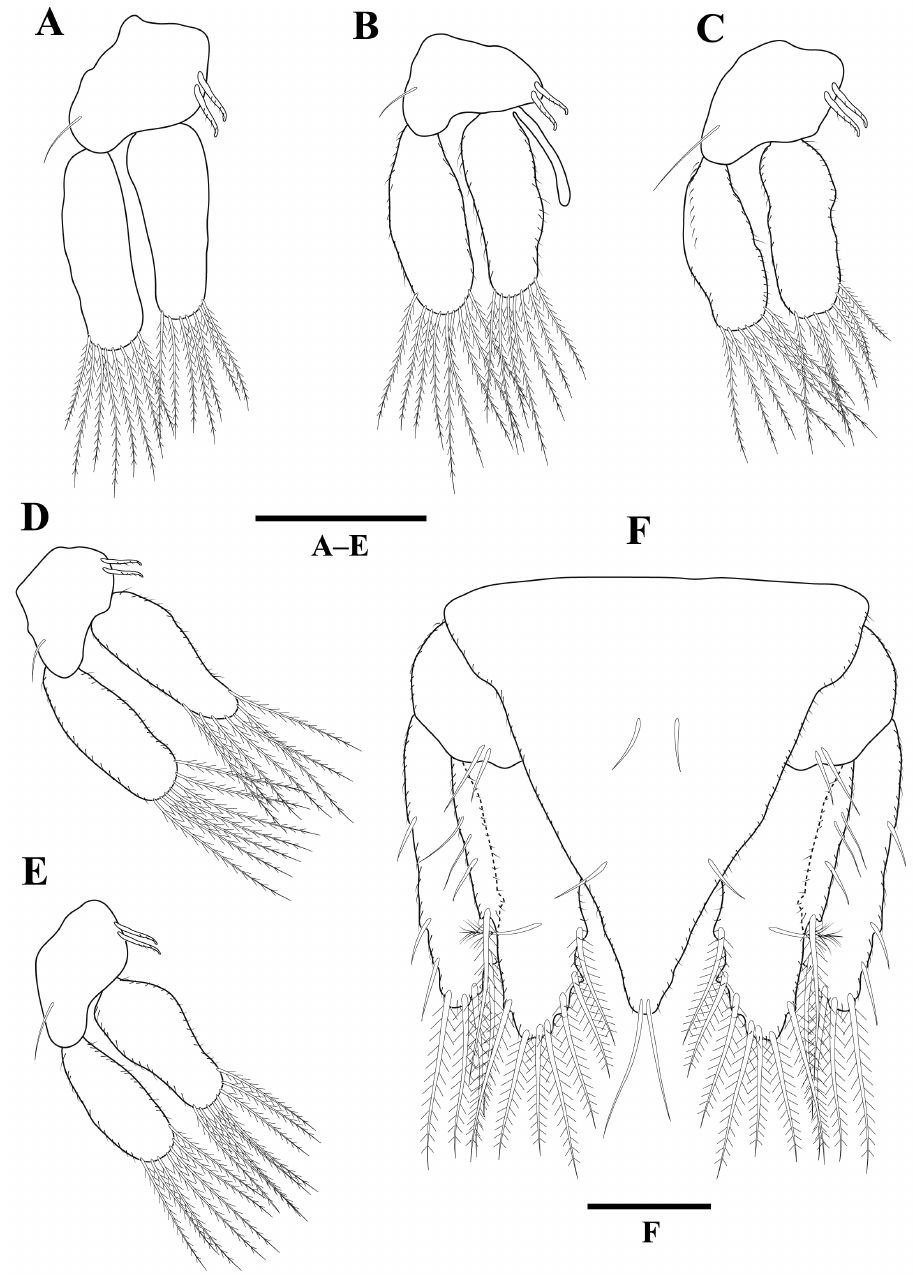
Figure 4. Gnathia koreana sp. n., male holotype A pleopod 1 B pleopod 2 C pleopod 3 D pleopod 4 E pleopod 5 F pleotelson and uropod. Scale bars: 0.2 mm ( A–E ), 0.1 mm ( F